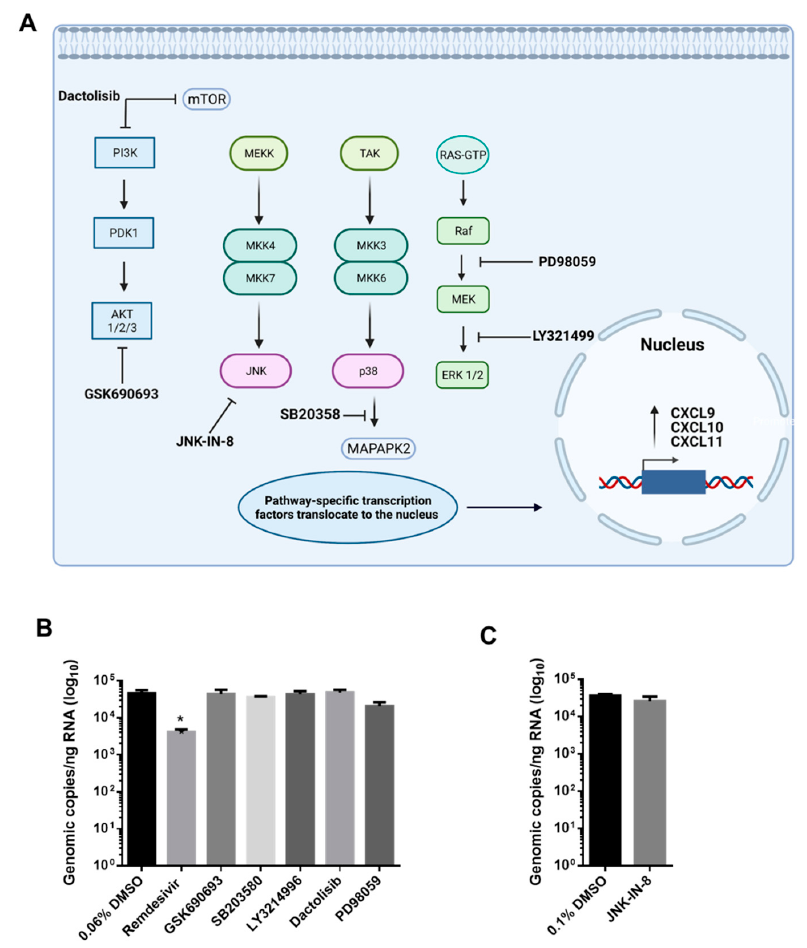
Figure 4. Kinase inhibitors targeting intracellular signaling-pathways that regulate CXCL9 , CXCL10 , and/or CXCL11 transcription do not affect SARS-CoV-2 RNA production. Created with BioRender.com. ( A ) Inhibitors of the pathways referenced, PI3K/AKT, JNK, p38 MAPK, and ERK/MEK were utilized to study chemokine transcriptional modulation. ( B ) Calu-3 cells were pretreated for 1 h with the indicated kinase inhibitor at nontoxic concentrations: Remdesivir (1 µM) control, GSK690693 (50 µM), SB203580 (25 µM), Dactolisib (10 nM), LY3214996 (100 nM), PD98059 (100 µM), and ( C ) JNK-IN-8 (5 µM). Cells were then infected with SARS-CoV-2 (MOI 1) and post-treated with the same inhibitor. Cell lysates were collected at 48 hpi and subjected to RNA isolation and RT-qPCR for the detection of SARS-CoV-2 intracellular RNA levels. Mean copy number (log10) ± SEM is shown ( n = 3 per time point). Significance was determined using the Student’s t -test; * p <